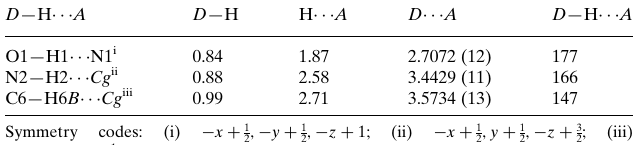
The title compound, C tautomer. The 12-membered macrocycle has a distorted chair conformation. In the crystal, molecules are linked via pairs of